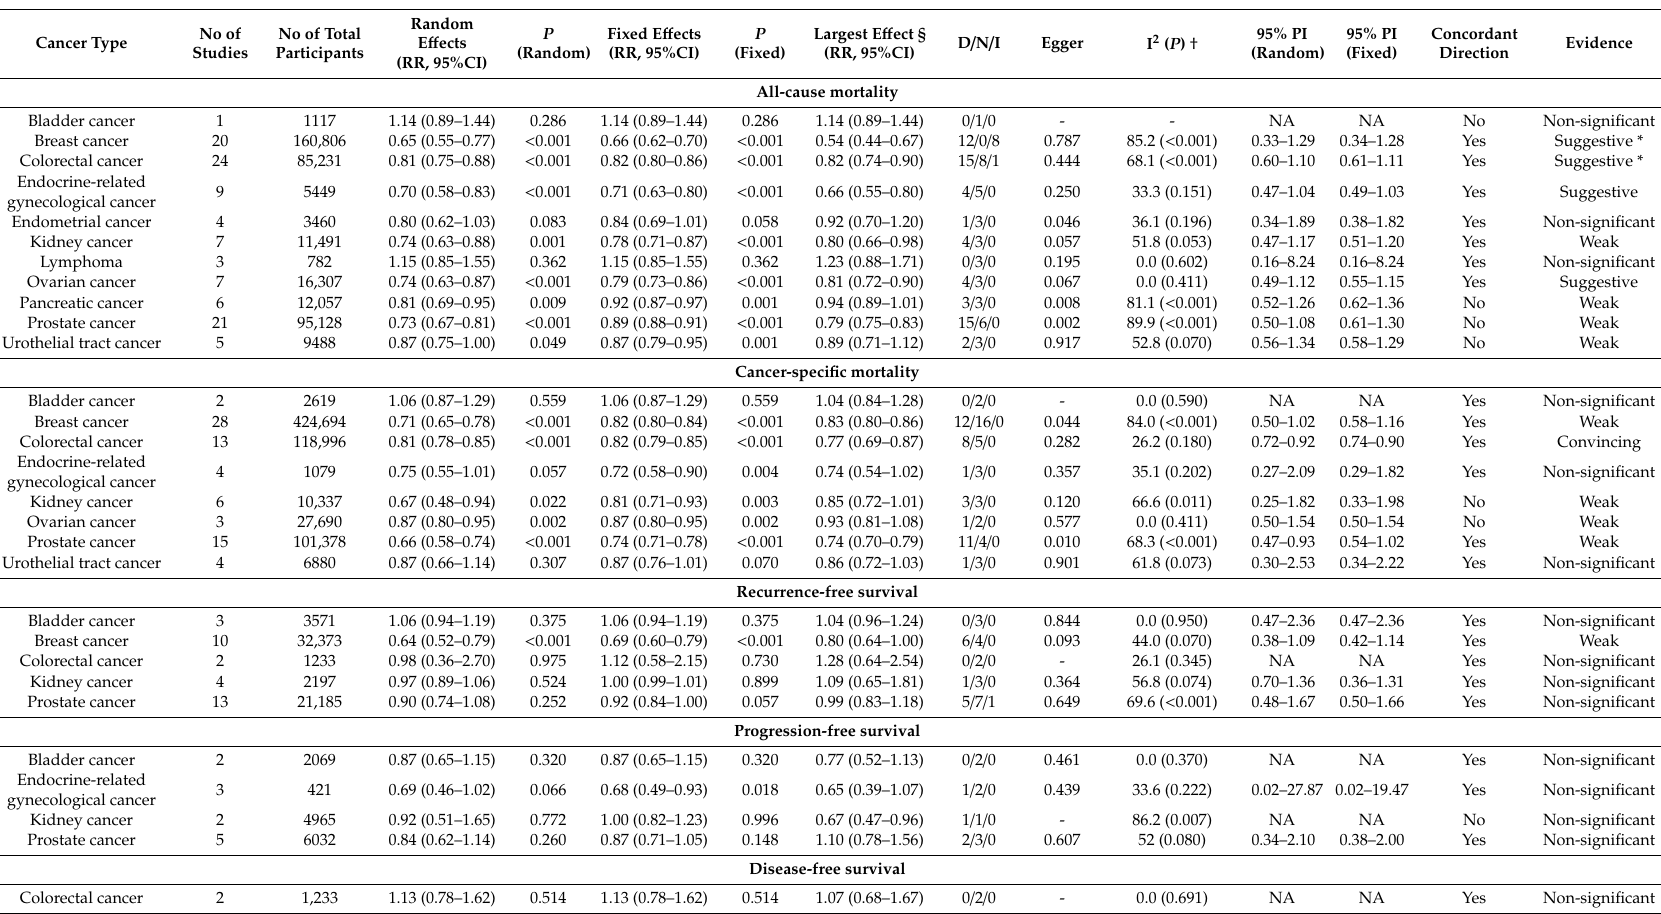
Table 4. Summary of the meta-analysis results by pooling all the datasets on associations of statin and the mortality or